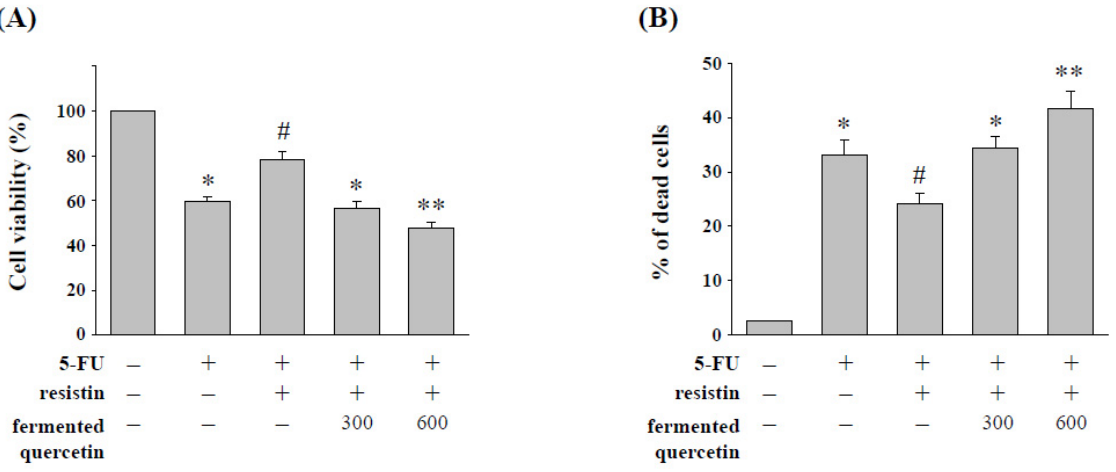
Figure 6. Fermented quercetin enhances 5-FU-induced cell cytotoxicity in HCT-116 cells with resistin stimulation. HCT-116 cells were kept as the control (CL) or treated with resistin for 12 h, then cultured in 5-FU for a further 48 h. After being treated with resistin, HCT-116 cells were treated with different doses of fermented quercetin (300–600 µ M) and then treated with 5-FU. ( A ) HCT-116 cell viability was assayed by the MTS assay. ( B ) HCT-116 cells were collected and stained with trypan blue dye, and the number of dead cells was manually counted. The percentage of trypan blue-positive cells represent the population of dead cells. Data represent the mean ± SEM from three independent experiments; * p < 0.05 vs. cells without treatment. # p < 0.05 vs. cells treated with 5-FU; ** p < 0.01 vs. cells treated with resistin and 5-FU.